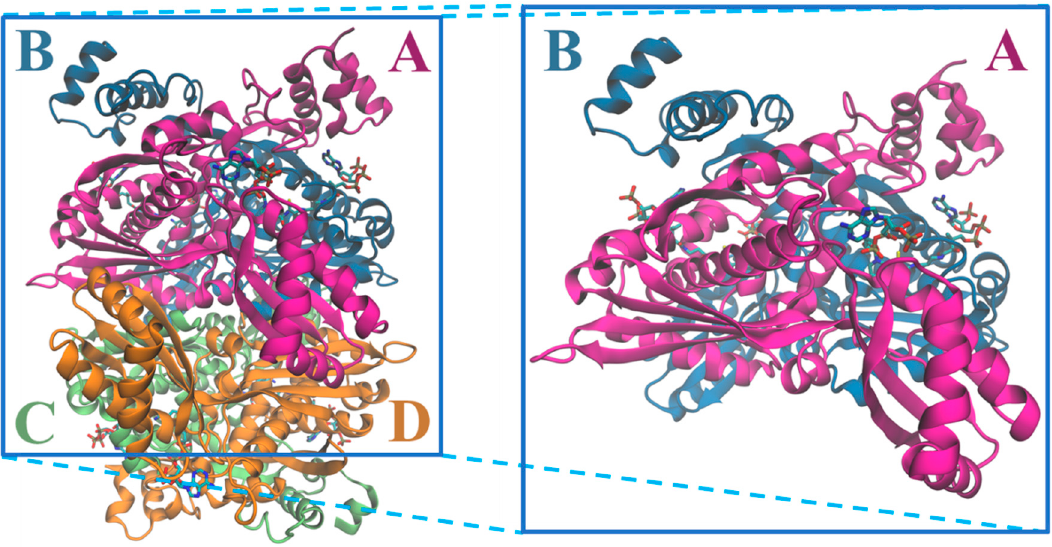
Figure 5. HMGCRs sequence alignment around the main catalytic residues, which are highlighted in yellow. The numbering is related to the human enzyme for Class I and with the Pseudomonas mevalonii one for Class II. Residues colored in grey are conserved between classes and those colored in light blue are conserved within the same class.